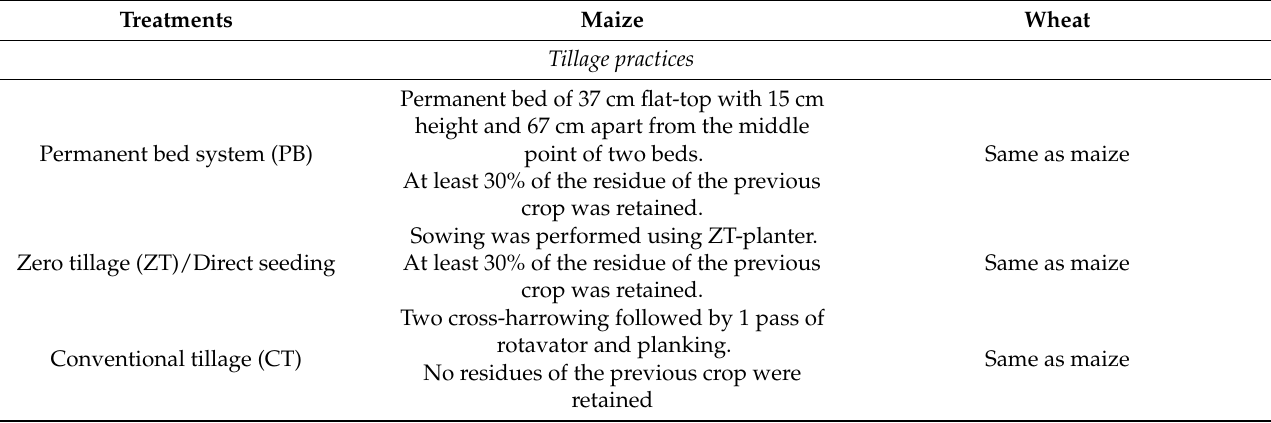
Table 2. Description of the treatments.